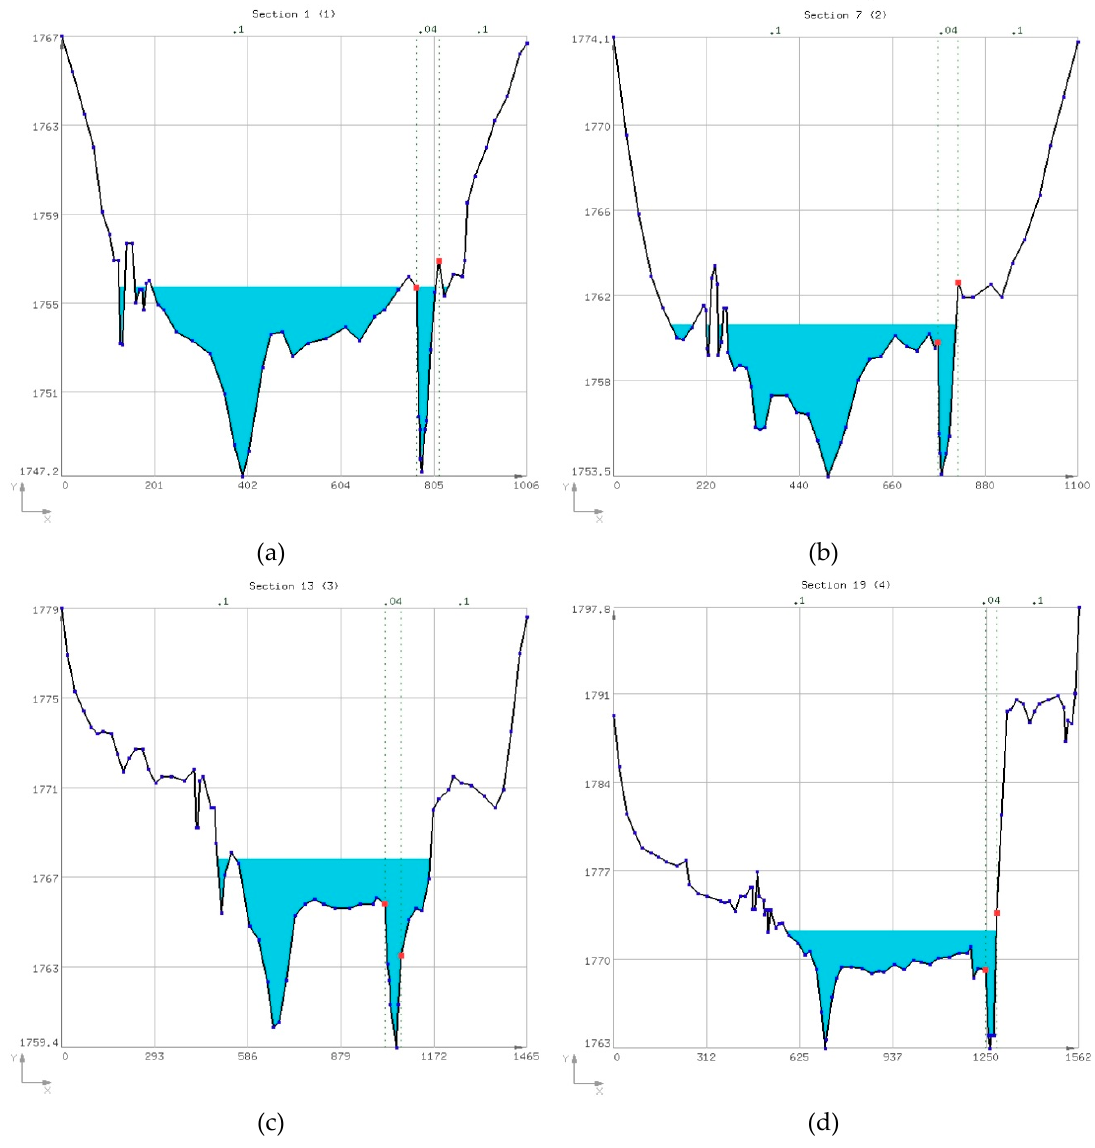
Figure 11. Sections of dataset 3 ( a ) section 1 with 61 points; ( b ) section 7 with 61 points; ( c ) section 13 with 69 points; and ( d ) section 19, with 85 points.